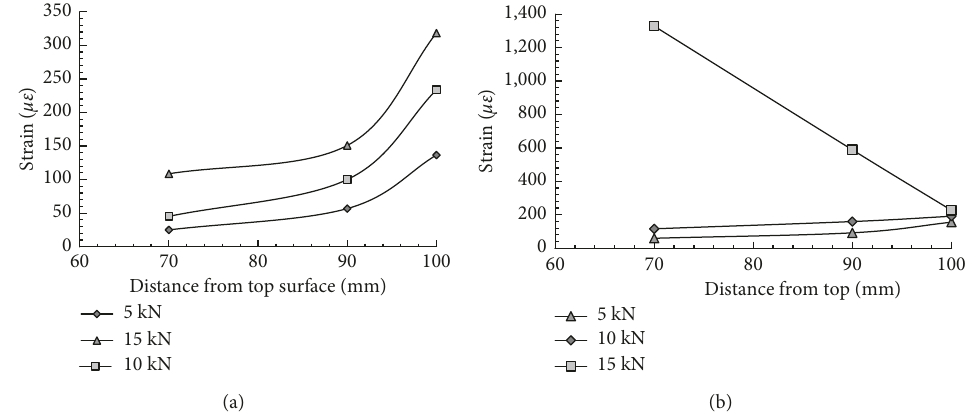
Figure 9: Strain distribution at the midspan section. (a) Fully bonded. (b) Unbonded.